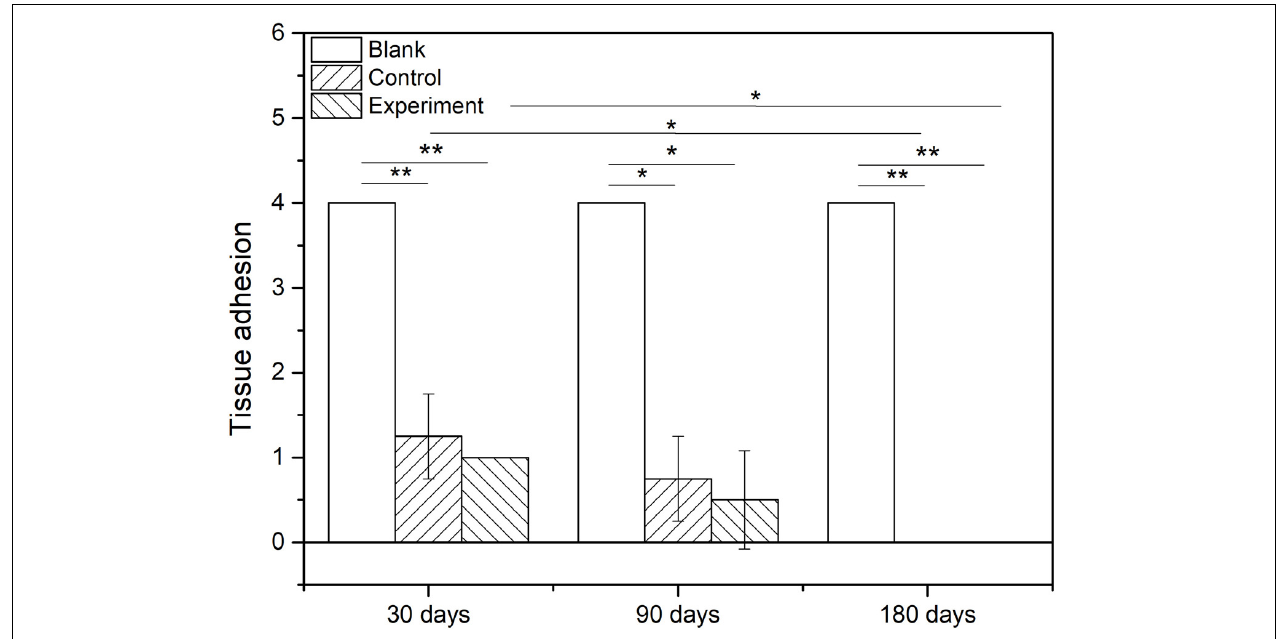
FIGURE 7 | The adhesion grading of implants with tissue (* P < 0.05, ** P <